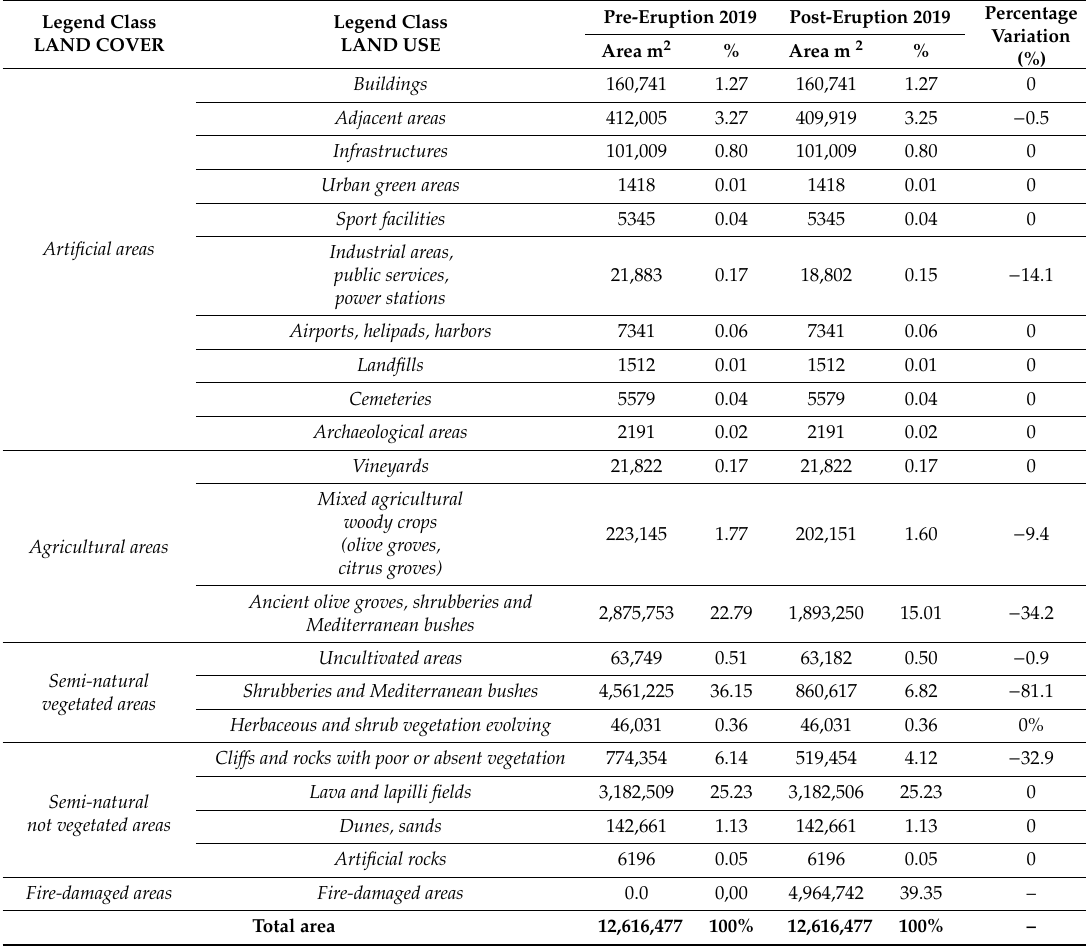
Table A1. Percentage variation of land cover / land use classes pre-eruption, sin- and post-eruption. Legend Class LAND